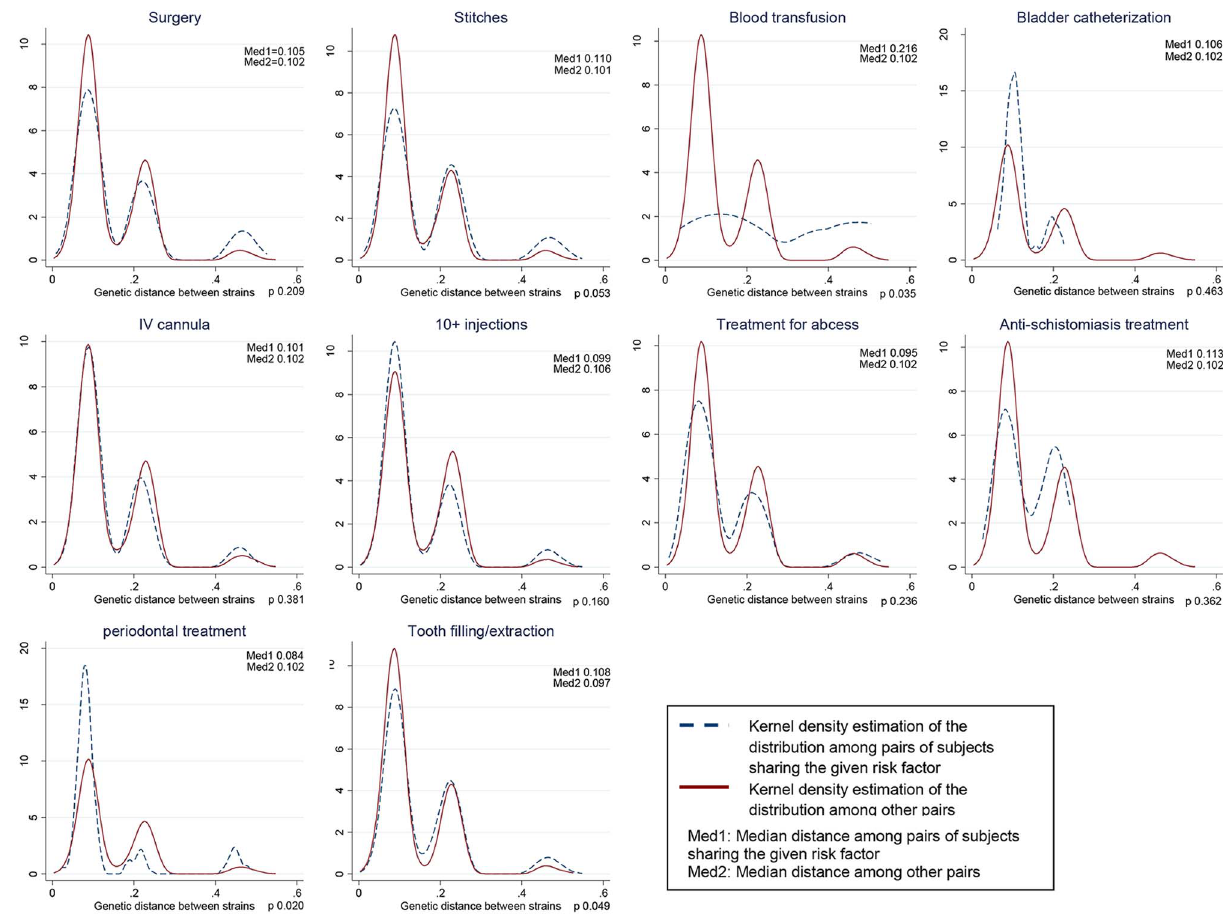
Figure 3. Distributions of viral genetic distances depending on iatrogenic exposure (n=133). Same interpretation as for Figure 2.